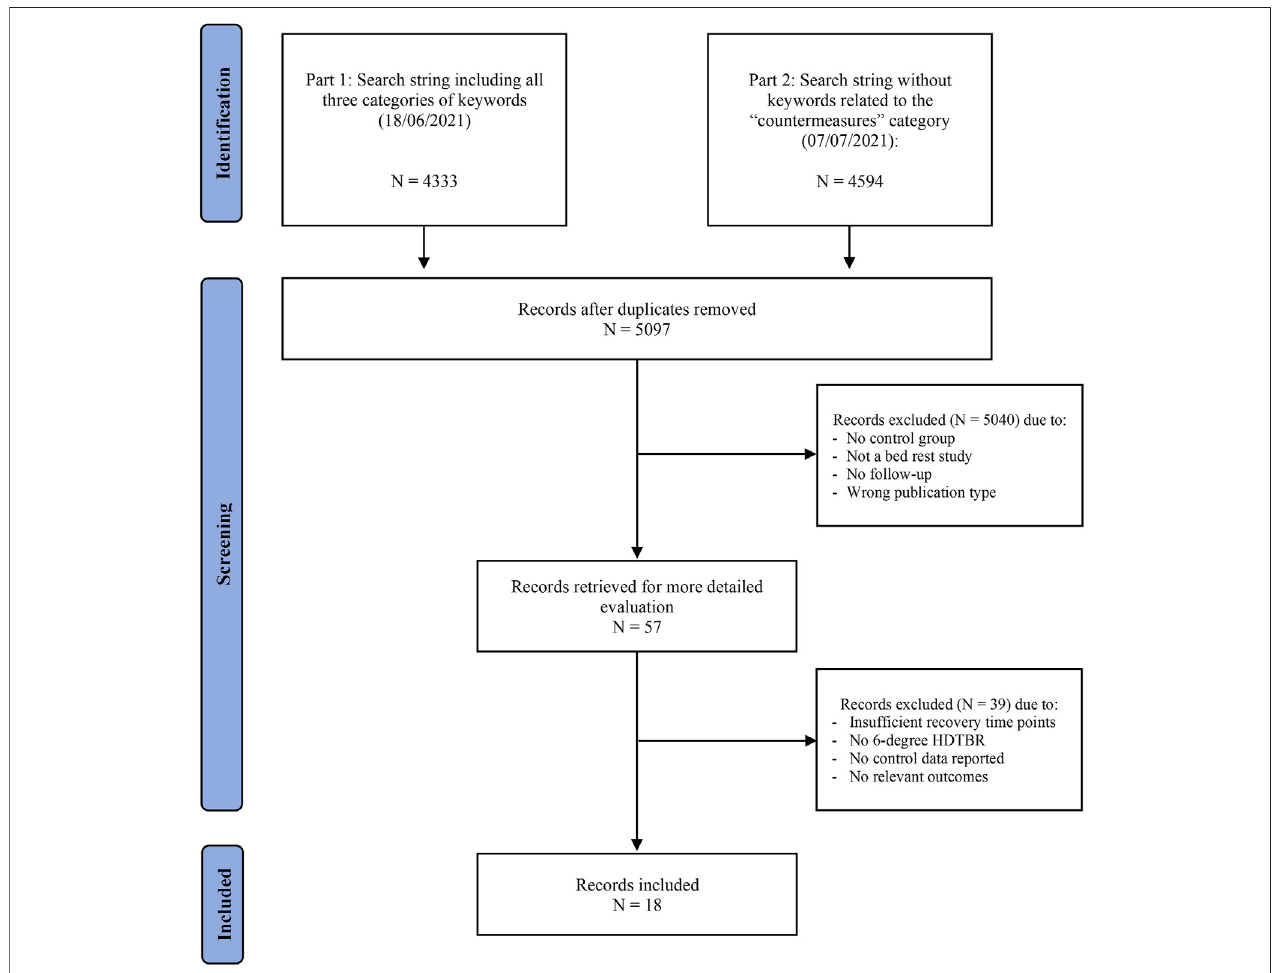
FIGURE 1 | Flowchart of the selection